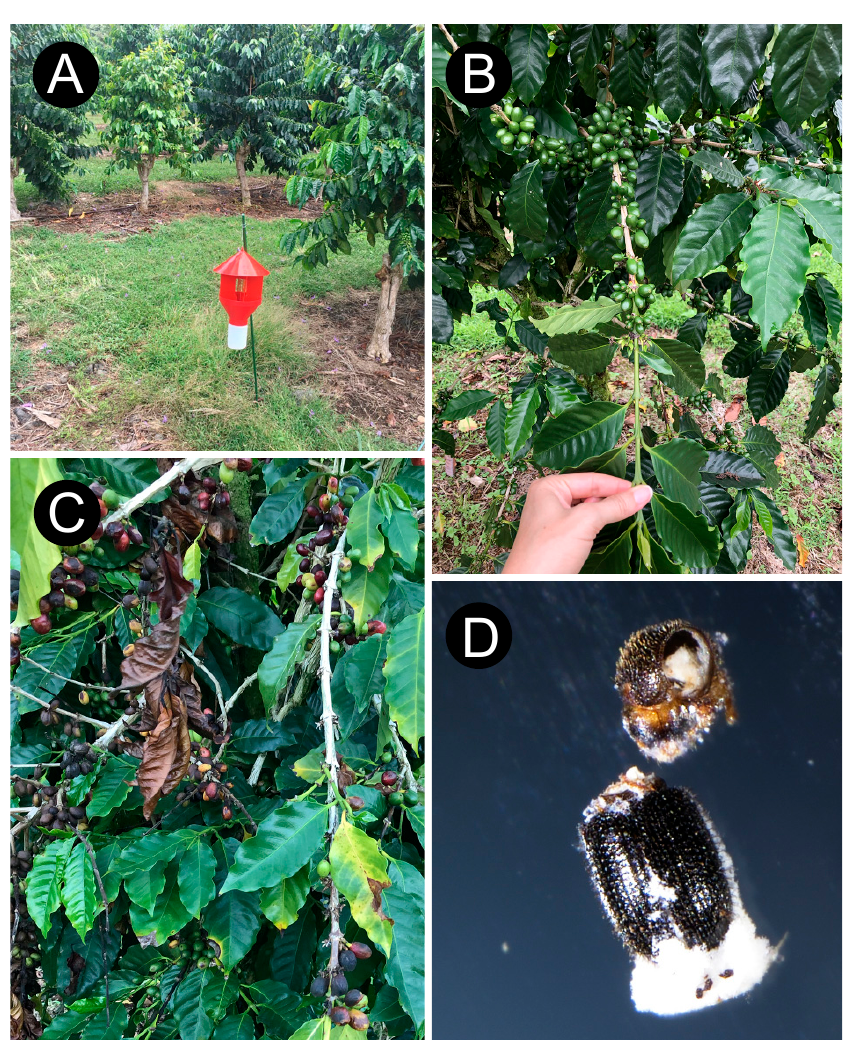
Figure 5. Essential components of a successful IPM program for CBB: monitoring flight activity using funnel traps baited with a 3:1 methanol:ethanol attractant ( A ); infestation assessment using the 30-tree sampling method ( B ); post-harvest sanitation of all berries, including over-ripe and raisin berries ( C ); and early season sprays of Beauveria bassiana fungus ( D ).